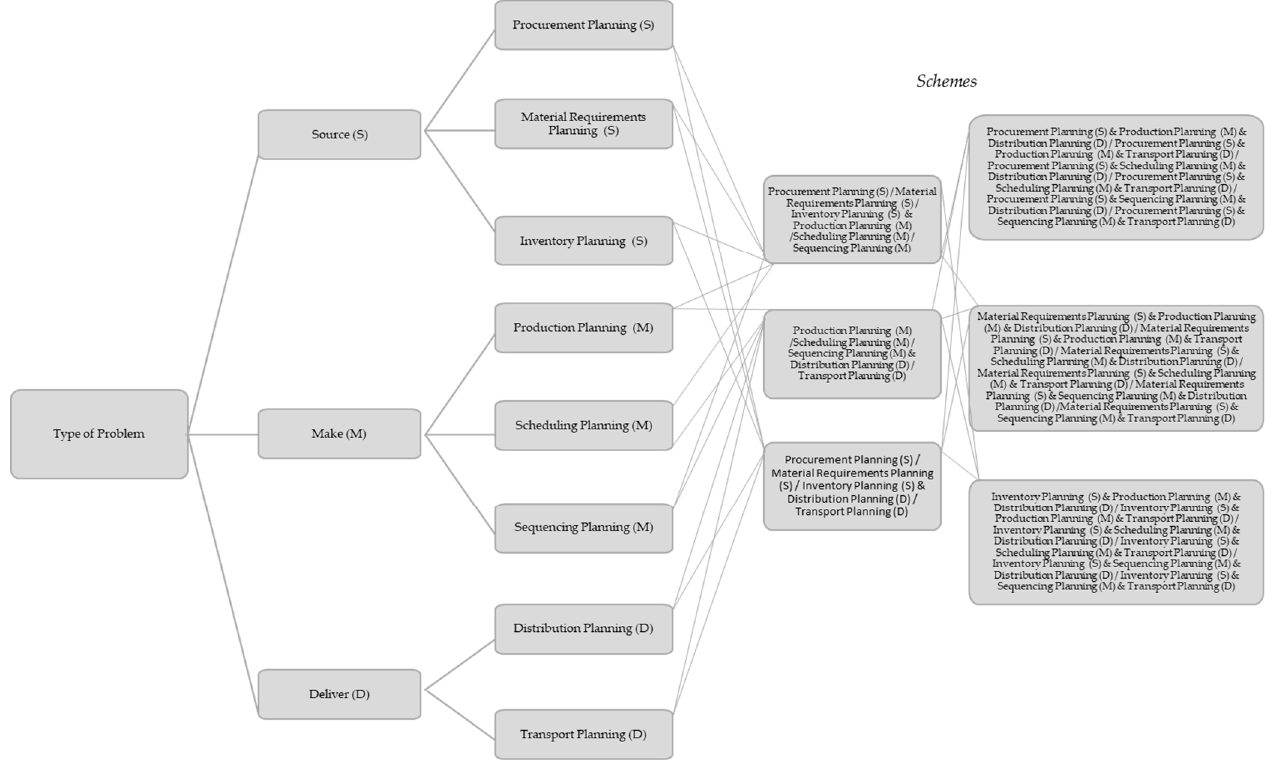
Figure 3. Replenishment, production and distribution planning problem types.